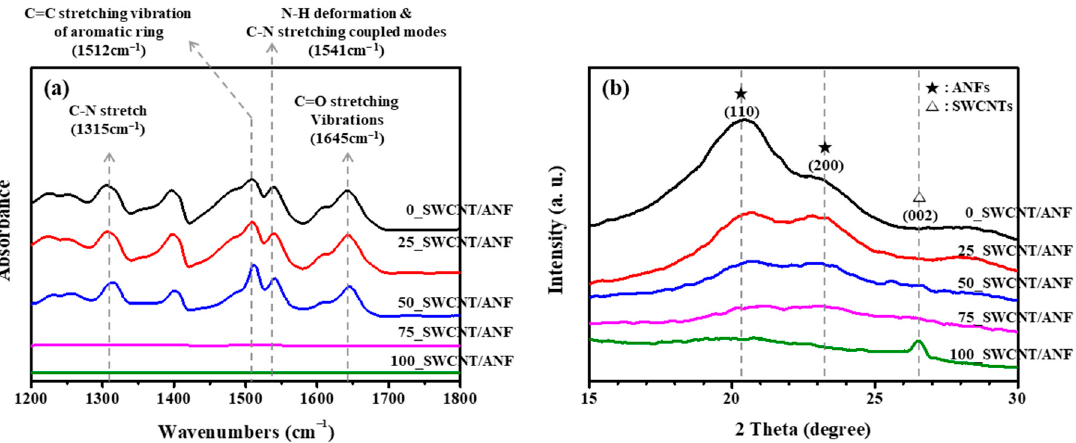
Figure 3. Characteristic curves of SWCNT/ANF composite sheets with varying SWCNT content. ( a ) IR absorbance spectra of aramid fibers and ANFs with wavenumbers between 1200 and 1800 cm − 1 , and ( b ) XRD spectra.